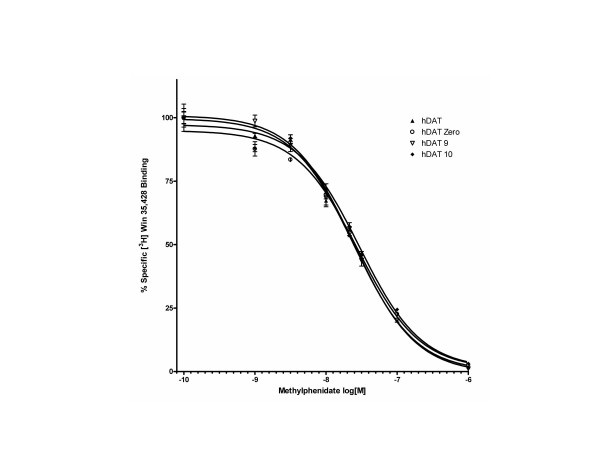
Representative Competition Binding Curves. No pharmacologically significant differences exist between DAT1 variants in the encoded protein's affinity for methylphenidate.